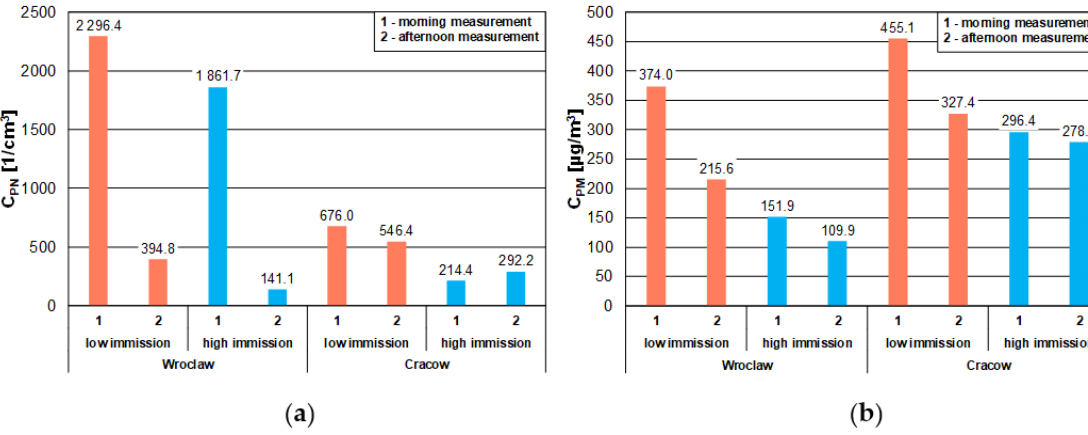
Figure 7. Low and high particle emission results in terms of: ( a ) number, ( b ) mass.